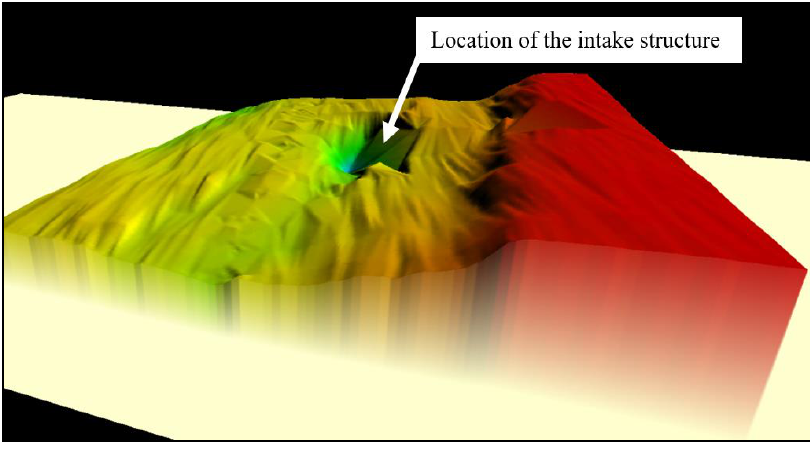
Figure 4. 3D bathymetric map used for model setup.